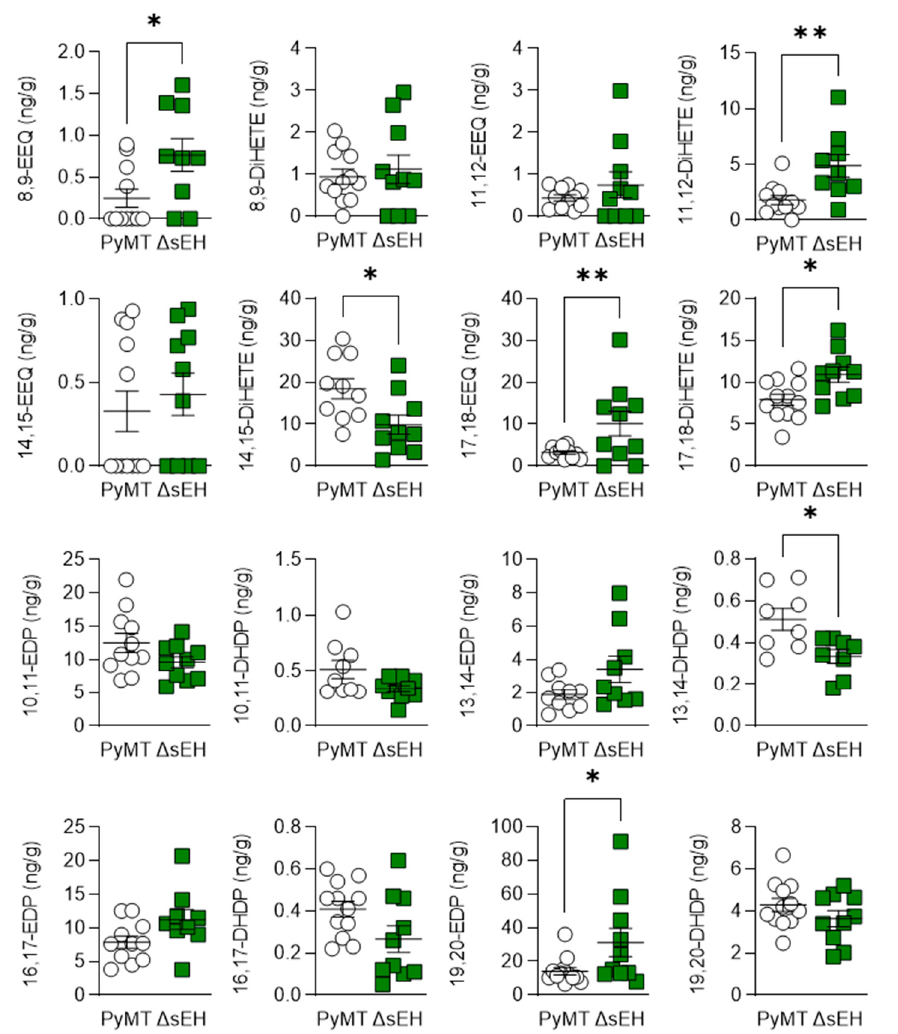
Figure 6. ω -3 PUFA epoxide and diol profiles. Primary tumors were isolated from 20-week-old PyMT and PyMT Δ sEH ( Δ sEH) mice and the PUFA epoxide and diol profiles were generated by LC–MS/MS. EEQ, epoxyeicosatetraenoic acid; DiHETE, dihydroxyeicosatetraenoic acid; EDP, epoxydocosapentaenoic acid; DHDP, dihydroxydocosapentaenoic acid. The graphs summarize data from breast tumors from 10–12 different animals in each group; * p < 0.05, ** p < 0.01 (Student’s t test).